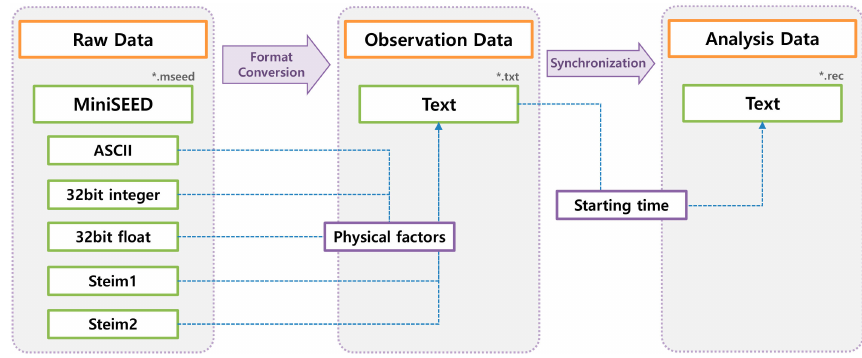
Figure 2. Conversion process from miniSEED to ASCII data formats.